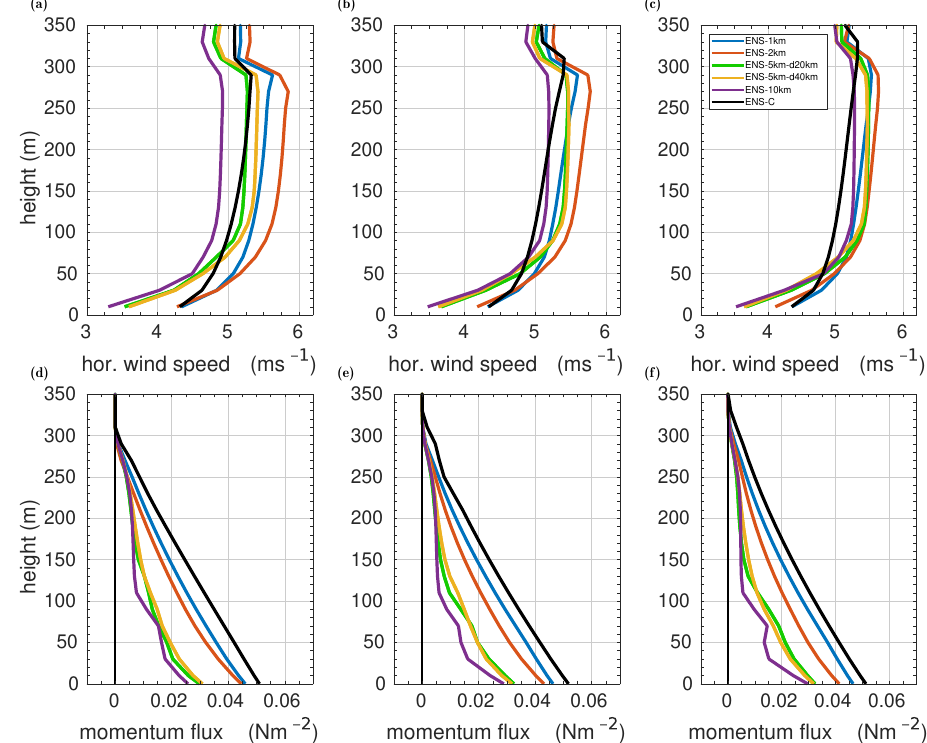
Figure 7. Same as Figure 6, but domain-averaged vertical profiles are shown for horizontal wind speed ( a – c ) and momentum fluxes ( d – f ). The figure is a modified version of a similar one shown by Michaelis